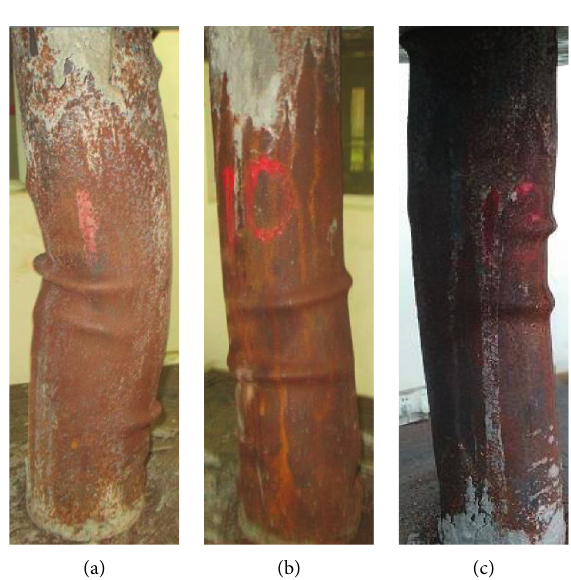
Figure 3: Typical failure modes of tested specimens. (a) TS-1. (b) TS-10. (c)